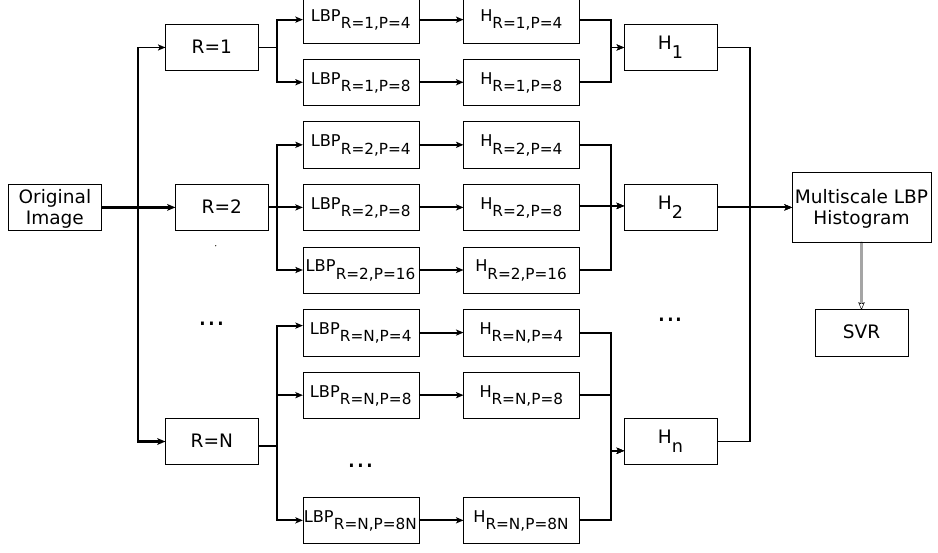
Figure 15. Feature extraction using MLBP